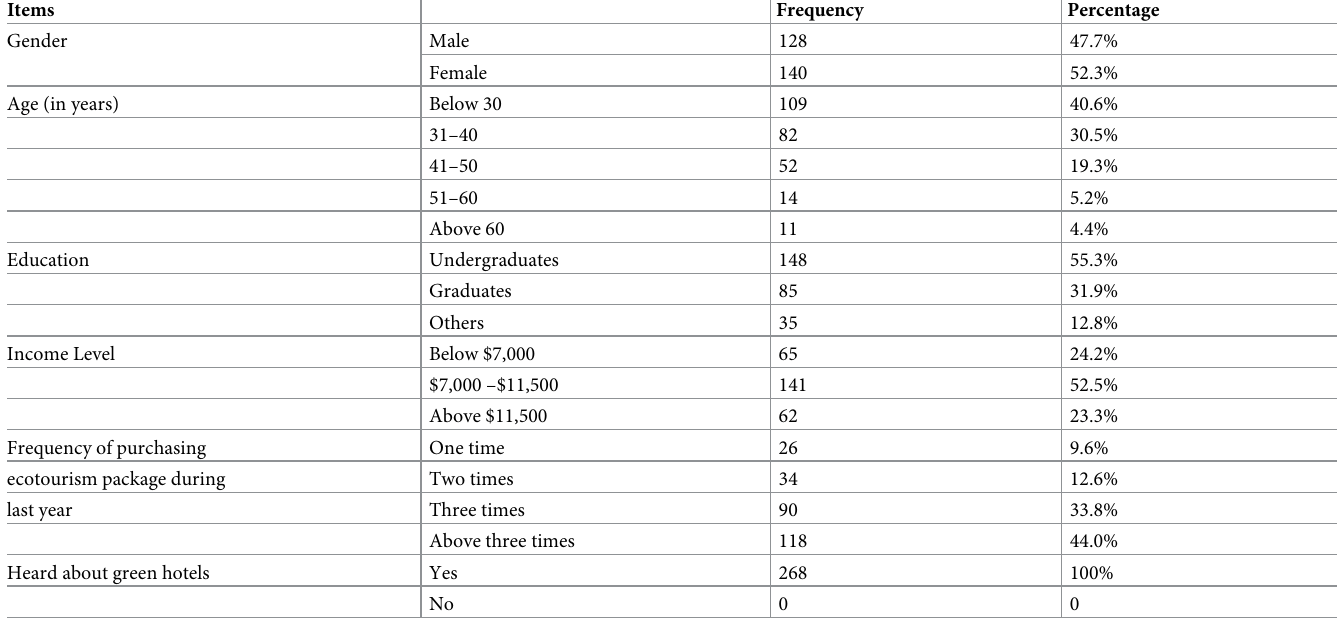
Table 3. Demographic profile (N =